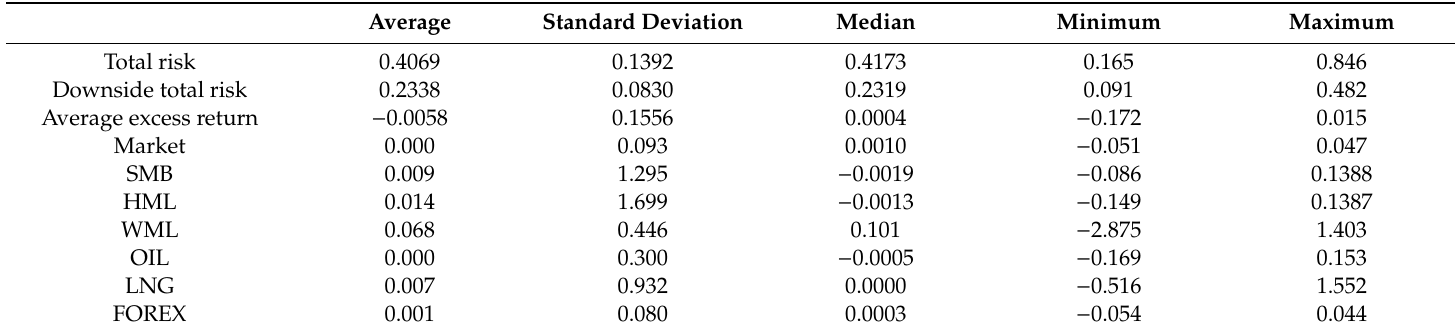
Table 2. Summary Statistics of